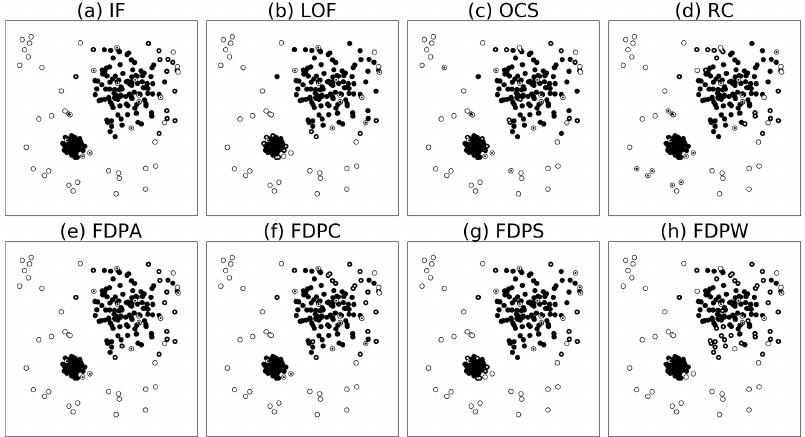
Figure 5. Outlier detection results of the algorithms on synthetic dataset D1. Outliers correct recognized are white points, insiders correct recognized are black points, outliers error recognized are white points with black core, and insiders error recognized are black points with white core.